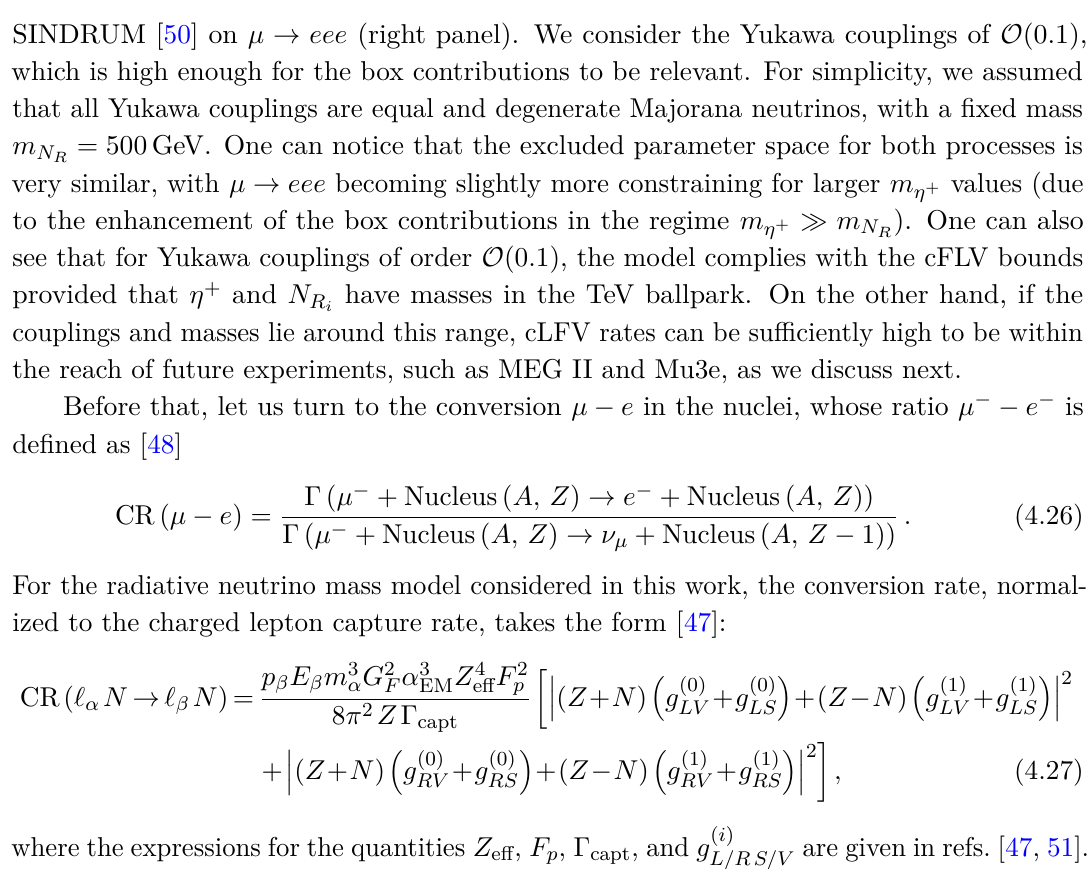
Figure 3 . Parameter space in the m − z iα plane consistent with the charged lepton flavor violation η + limits. The colored regions are allowed by the current